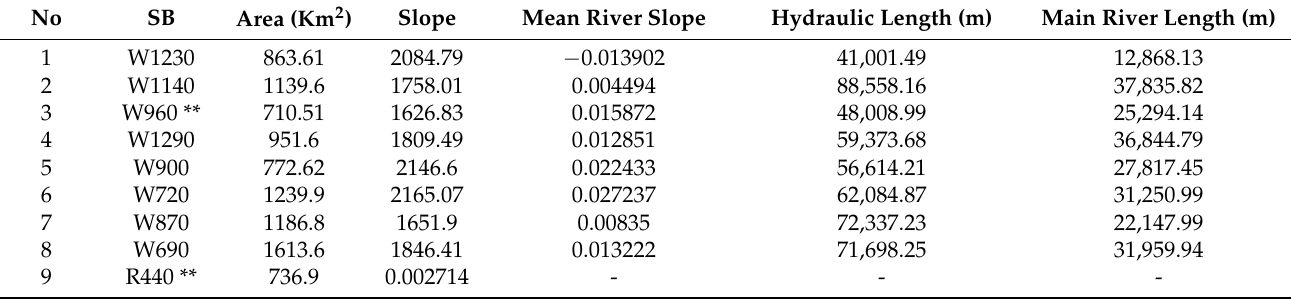
Table 3. Physiographic characteristics of the delineated Nyabarongo